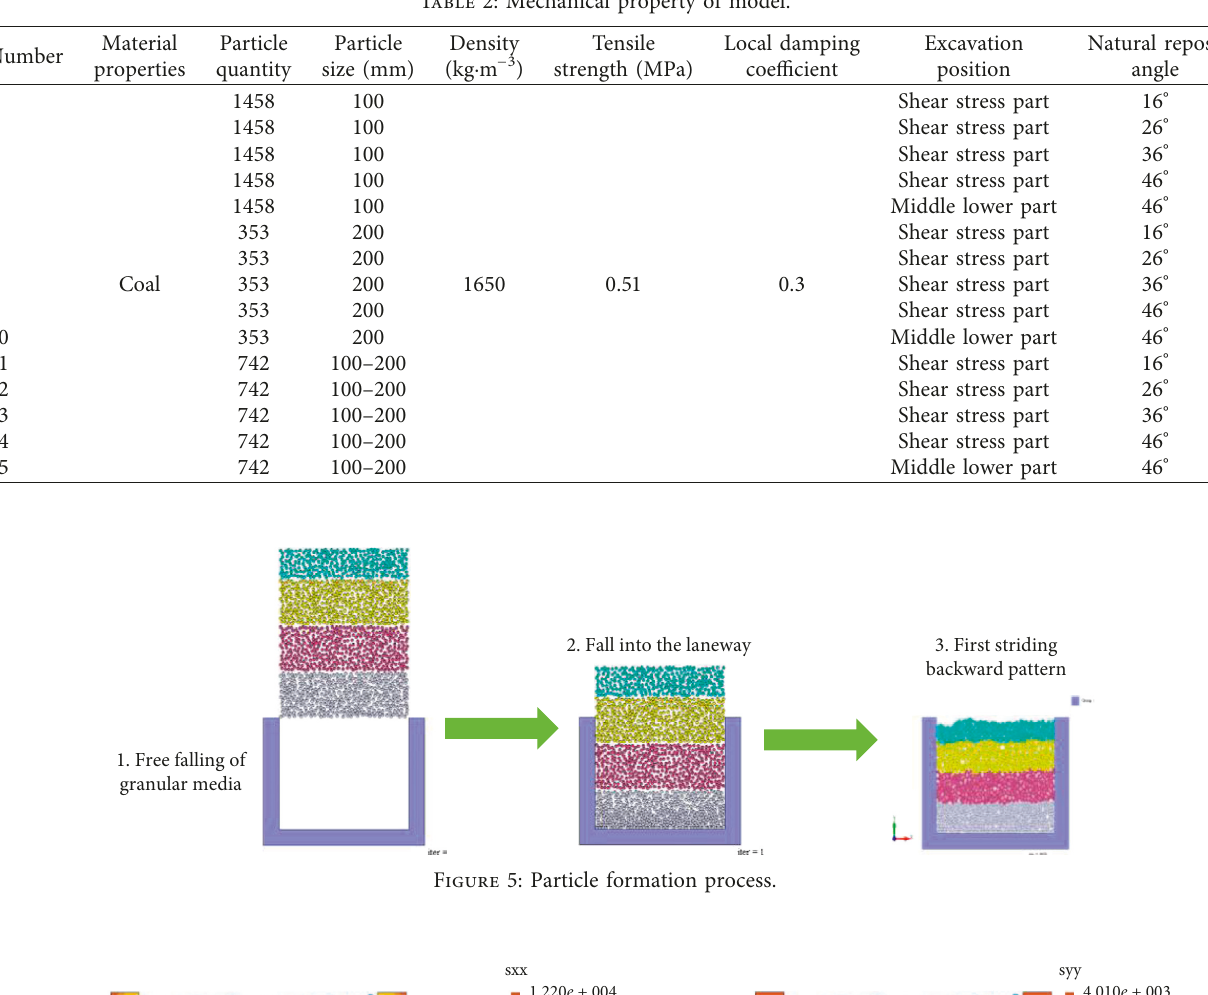
Table 2: Mechanical property of model.